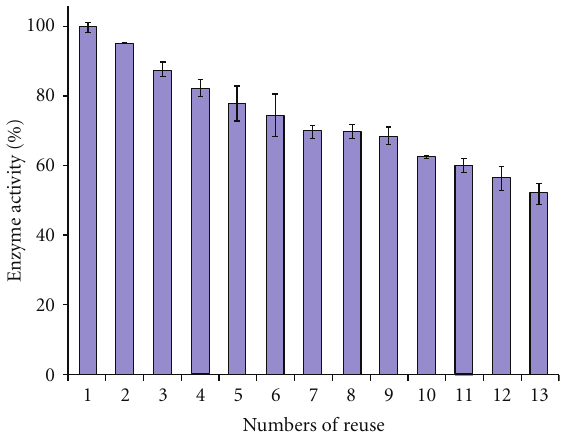
Figure 5: Evaluation of peroxidade activity maintenance after repeated use of HRP-PANImG with H 2 O 2 in lower concentration (2.5mmolL − 1